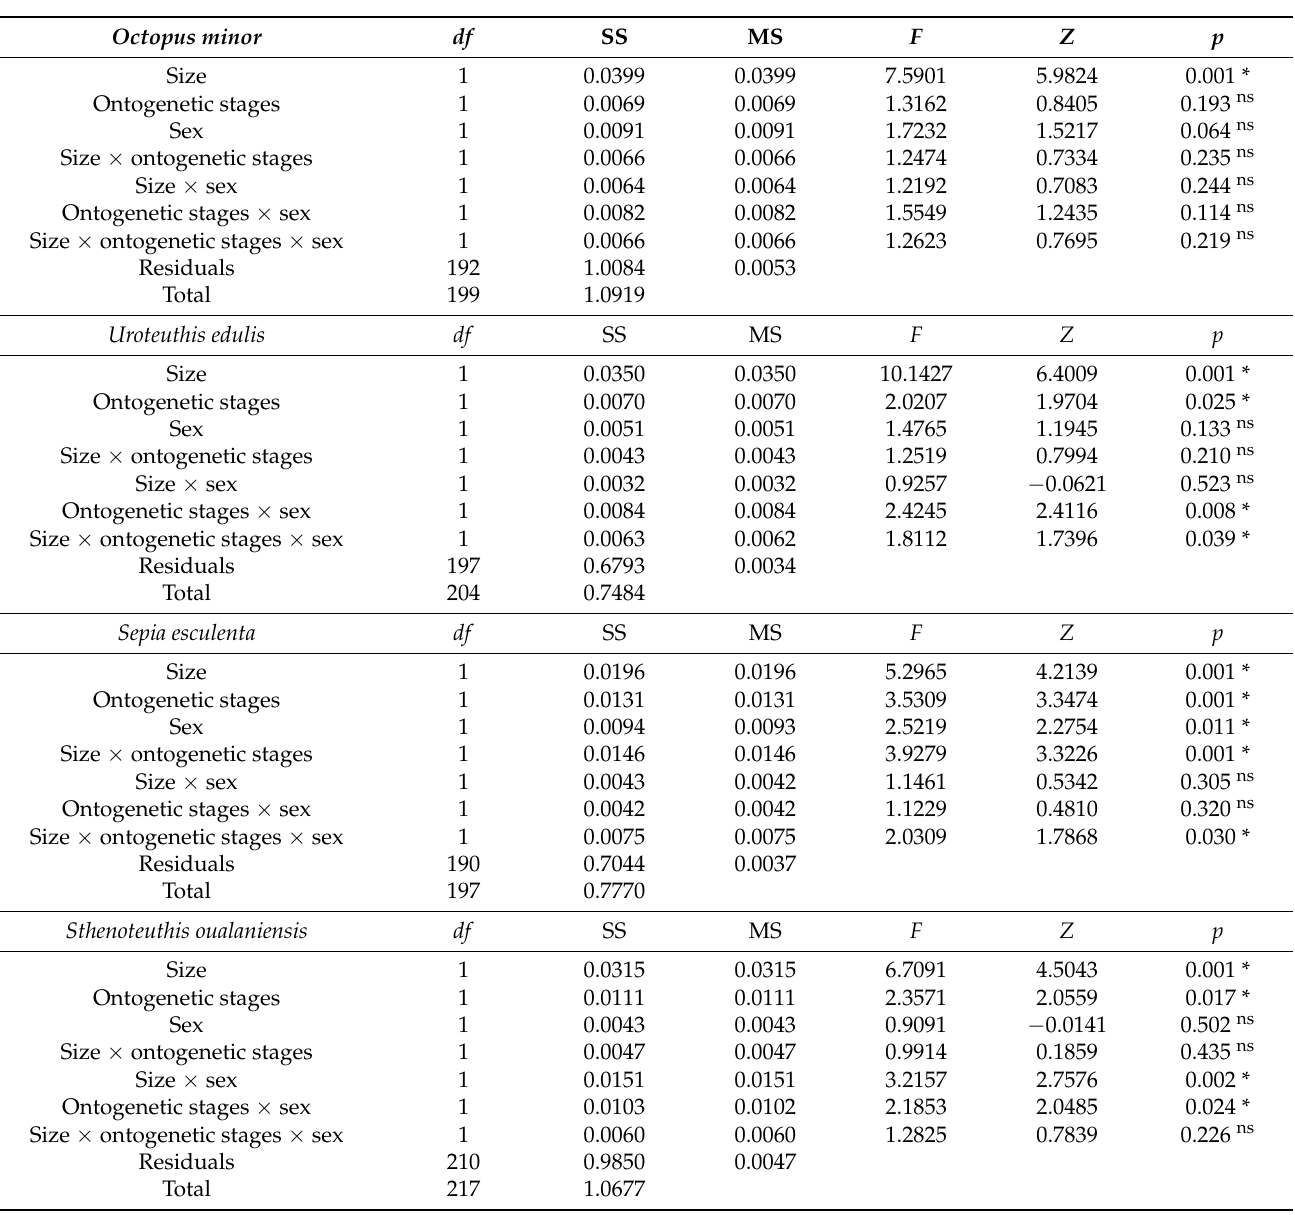
Table 3. Procrustes ANOVA of the shapes of lower beaks of the four cephalopods considered in different ontogenetic